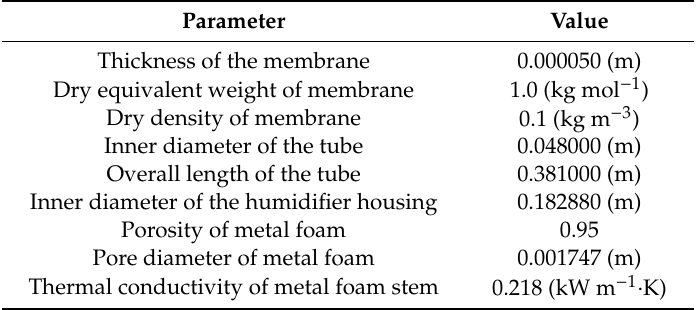
Table 1. Parameters of a porous metal foam membrane